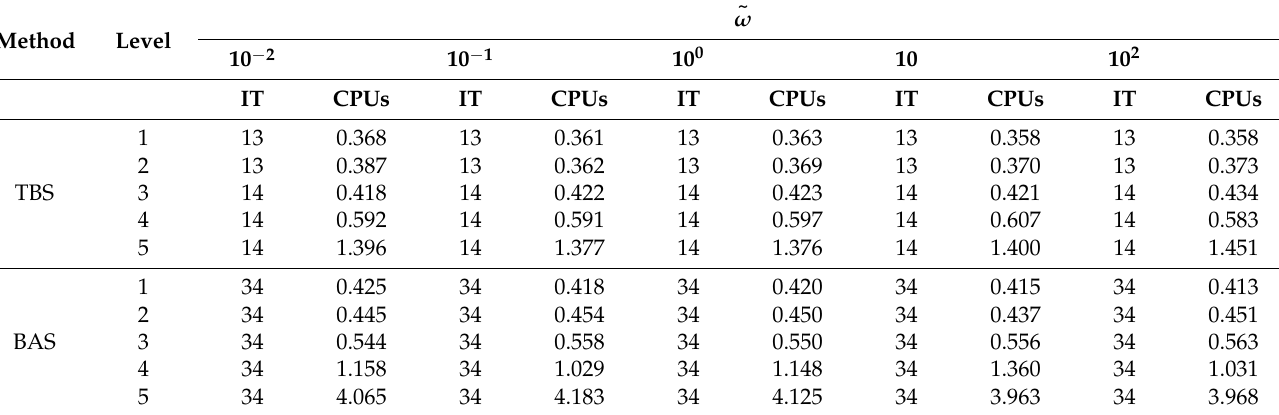
Table 8. Different mesh refinement levels and (cid:101) ω , the results of the iteration method in the 2D case, with ε = 10 − 4 . Method